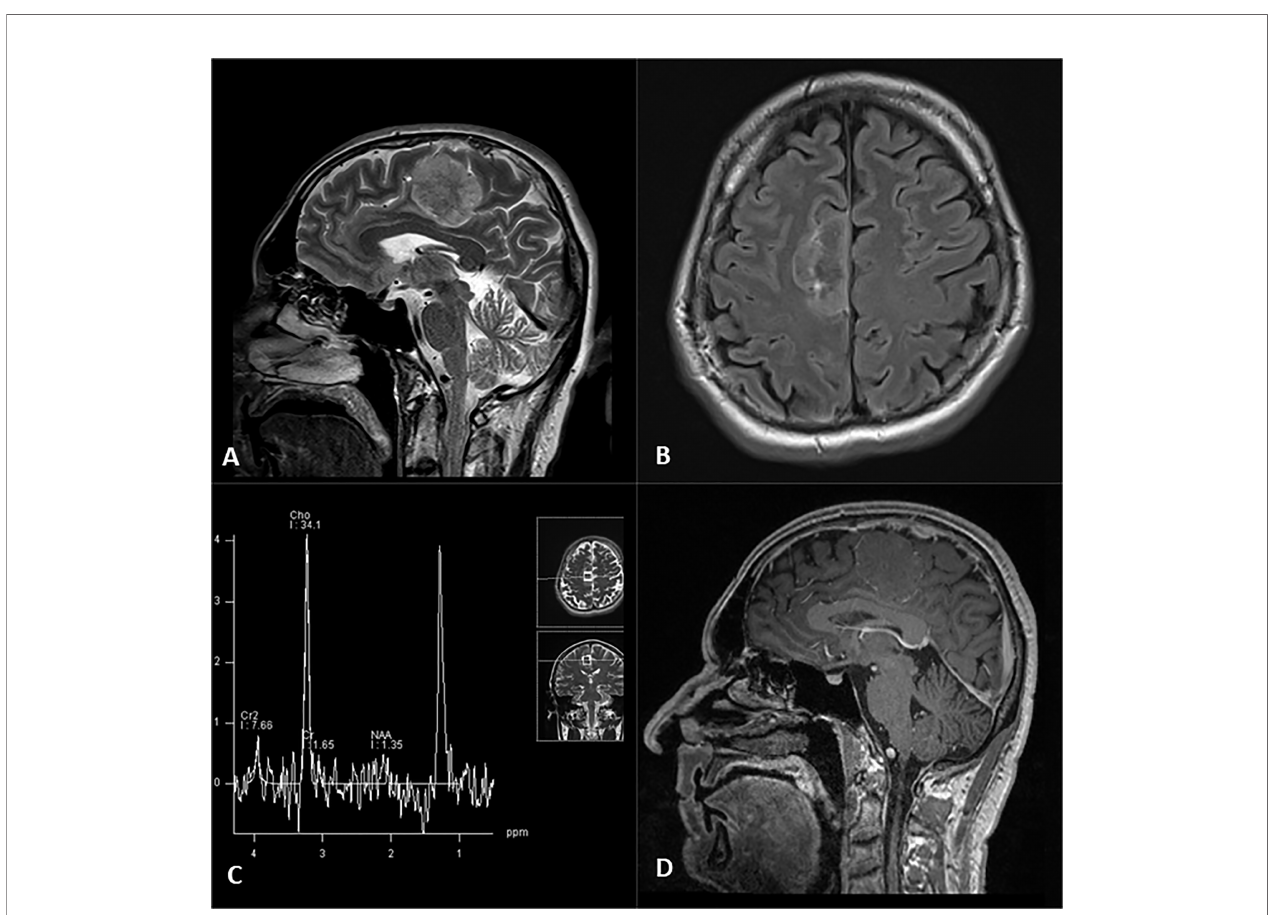
FIGURE 1 | Right frontal parafalcine tumor evident on T2 sagittal (A) and FLAIR axial images (B) , associated with typical high choline and lipid peaks on single-voxel MR spectroscopy (C) and lack of expected enhancement on post contrast T1 sagittal image (D)